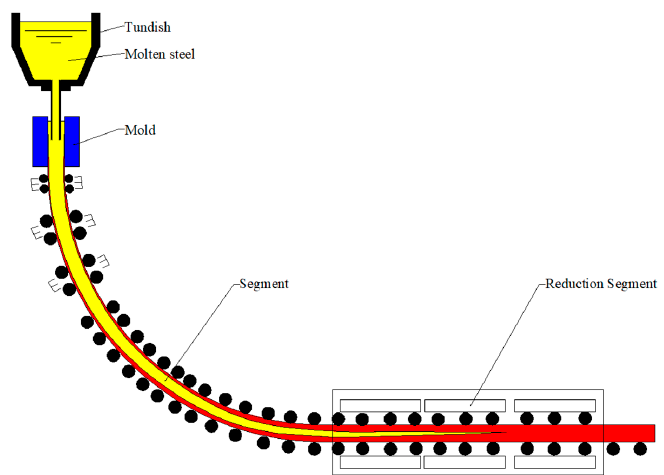
Figure 1. Continuous casting process.